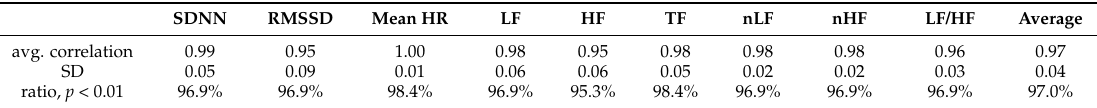
Table 3. The average correlation, SD and ratio of the correlations whose p -values are less than 0.01. SDNN RMSSD Mean HR LF HF ratio, p < 0.01